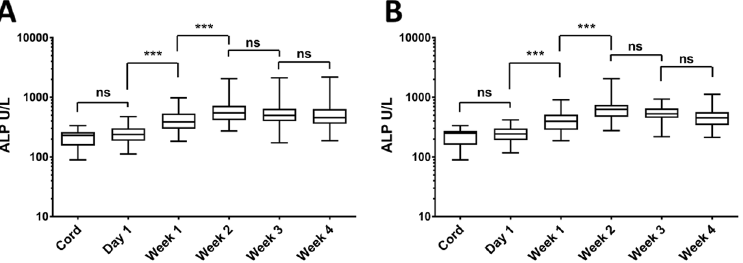
Fig 2. Ontogeny of plasma ALP in the first 4 weeks of life for pre-term newborns. Significance tests use repeatedmeasureslinear regression. Figure shows boxplotsfor all pre-term samples(A) or for only pre-term subjectswithout HCA or LOS (B). ** p < 0.01,and *** p < 0.001.